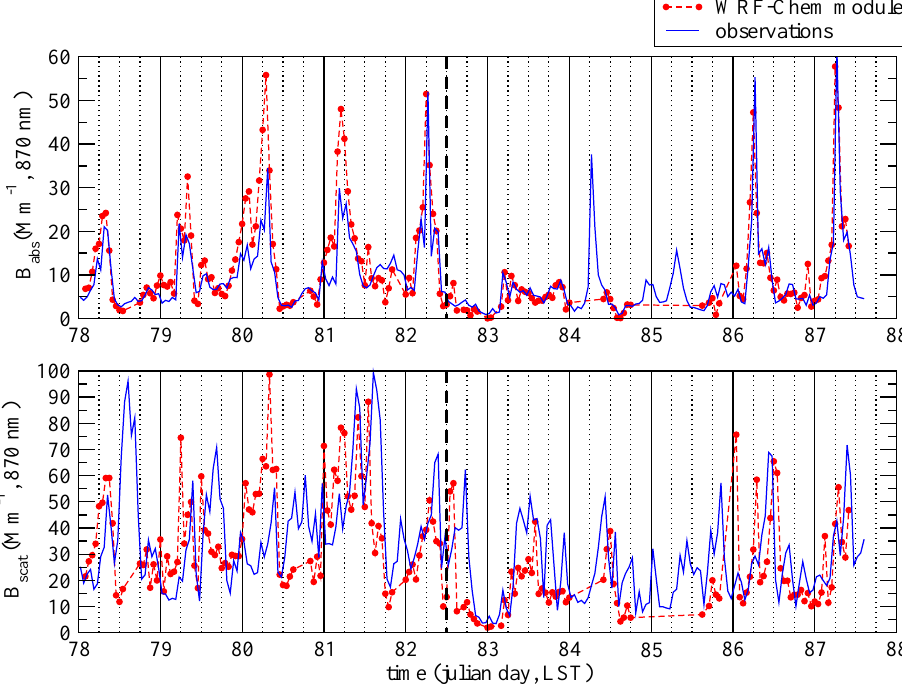
Fig. 5. The top panel shows the absorption coefficient, B abs , while the bottom panel shows the scattering coefficient, B scat . The blue lines indicate the observations, while the red dots show simulations of these coefficients derived from the WRF-Chem “chemical to optical properties” module. Hourly averages are shown. The dashed red line that connects the dots aids in the comparison between the simulations and observations. Note that there are significant time periods when missing data prevented a simulation from taking place; for example, the time span from the end of day 84 continuing on through most of day 85. We again note for convenience that day 78 is 19 March 2006. The vertical, bold dashed line that occurs at time 82.5 separates the clear (julian day < 82.5) and showery (julian day ≥ 82.5) periods.